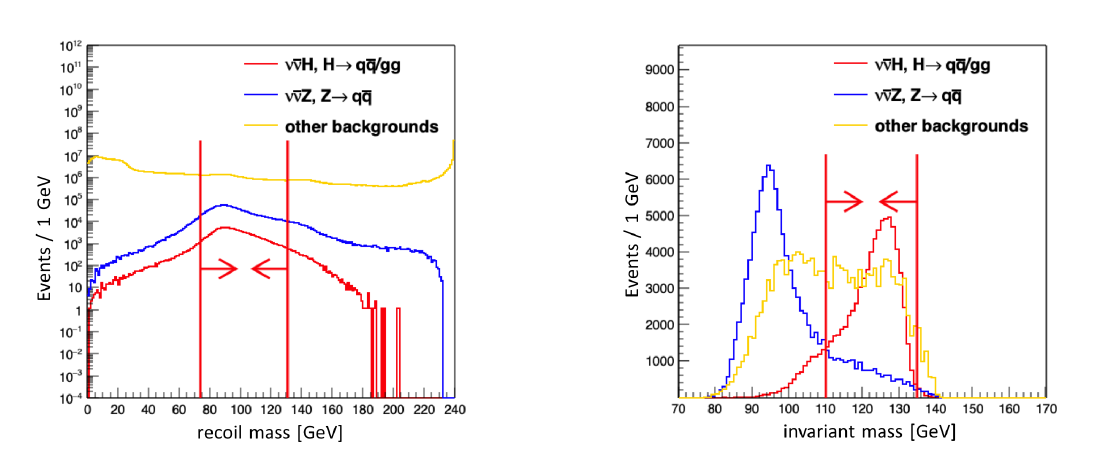
Figure 5 . The distributions of the recoil mass of all SM samples and of the invariant mass of SM samples after the Y23 cut for ν ¯ νHq ¯ q , ν ¯ νZq ¯ q , and other backgrounds are shown in the left plot and right plot,